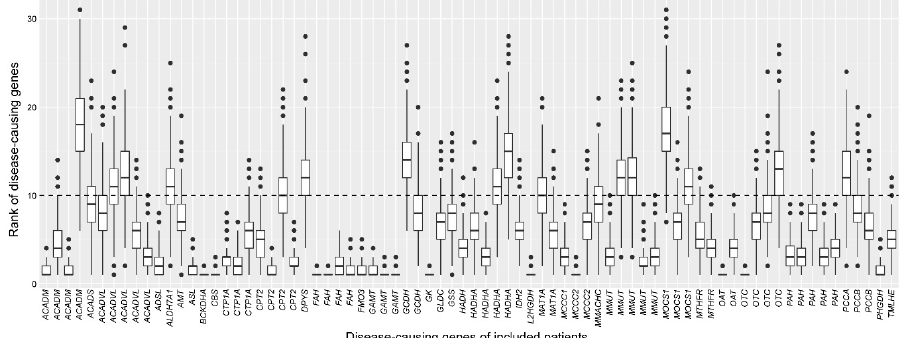
Figure 5. Robustness of the cross-omics method on a within-patient basis. The consistency of the ranks of the disease-causing genes across 1000 analyses is demonstrated by boxplots, for the most favorable parameter combination: maximum distance to primary reaction = 4, extension stringency threshold <15, biochemical stringency paired Z-score threshold is < − 3.0 or >3.0. Disease-causing genes of individual patients are depicted on the x -axis; the ranks of the disease-causing genes are depicted on the y -axis. The horizontal dashed line at y = 10 depicts the maximum rank of the disease-causing gene that was considered to be prioritized correctly. All 21 patients whose disease-causing genes were missed were omitted from this figure.